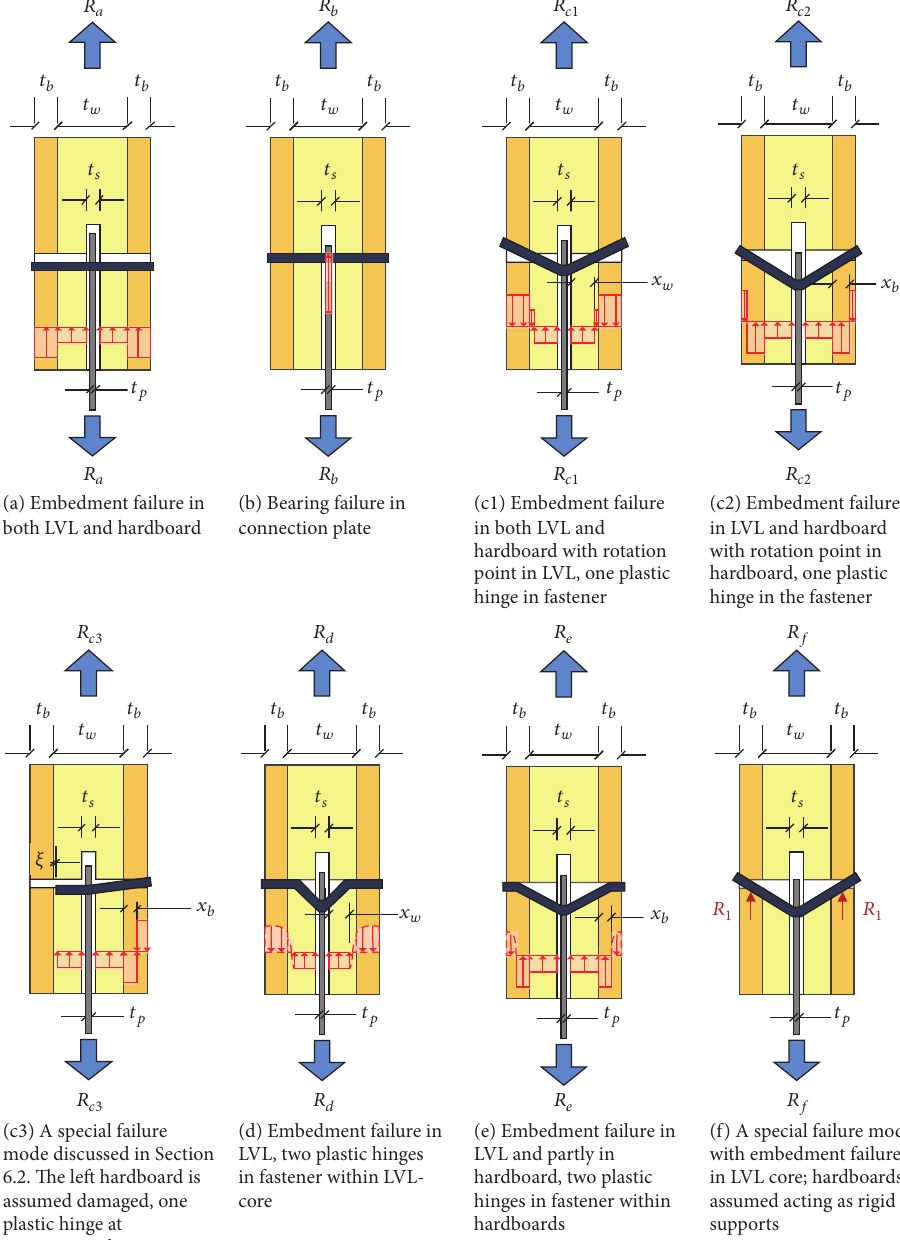
Figure14:Possiblefailuremodes(a)–(f)fortheslotted-insteelplateto PlyBoardpanelconnection.Theforcedirectioncorrespondstovertical uplift and is parallel to the grain direction of the LVL core. In the case of horizontal shear the force acts perpendicular to the grain orientation of the LVL core, although the failure mode is principally the same. The influence of edge and end distances is not considered (it is assumed that the edge and end distances proposed in Section 4.7 are applied); the notation and data of the cross-sectional parameters of the PlyBoard test specimens are 𝑡 𝑏 = board thickness (8mm), 𝑡 𝑤 = LVL thickness (26mm), 𝑡 𝑠 = slot thickness (4mm), and 𝑡 𝑝 = steel-plate thickness